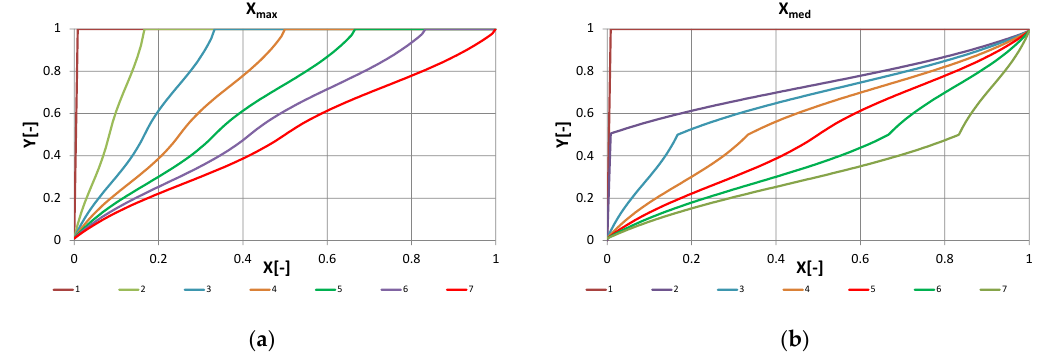
Figure 4. Output signal of the FC under two different types of membership function deformations. ( a ) (H)-FC family; ( b ) (M)-FC family.